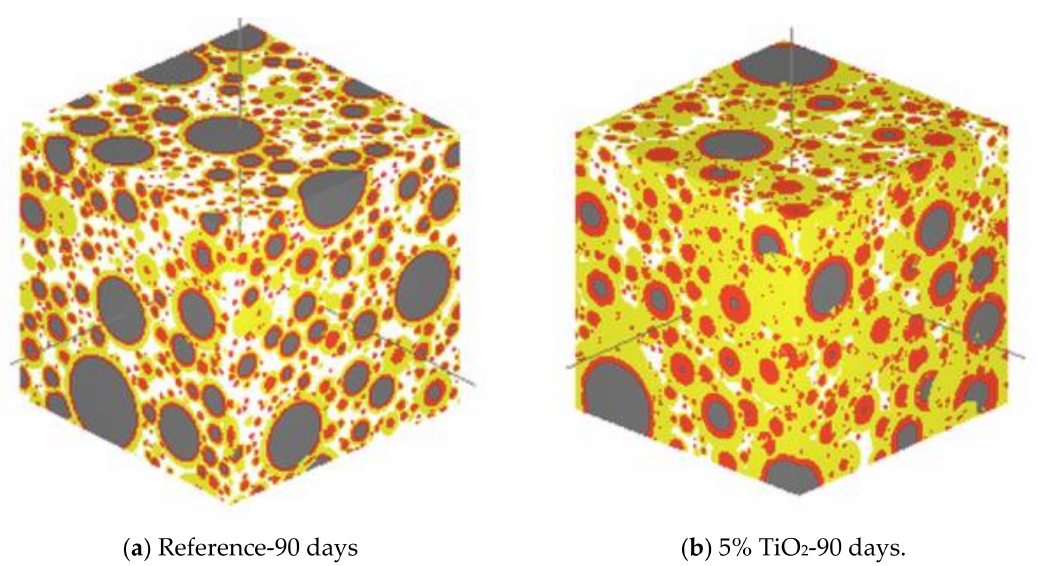
Figure 3. Formation of the microstructures in the cementitious material with or without nano-TiO 2 (grey part: Unreacted particles; red part: Inner products; yellow part: Outer products; white part: Pores). Reproduced from [33], with permission from Elsevier,